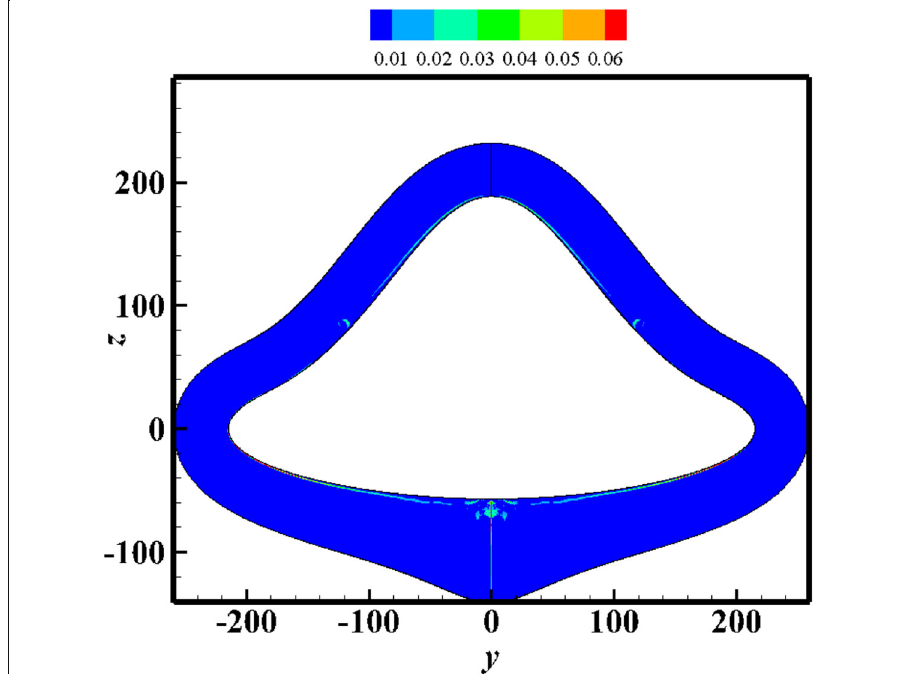
Fig. 12 The streamwise vortex at x = 1200 mm